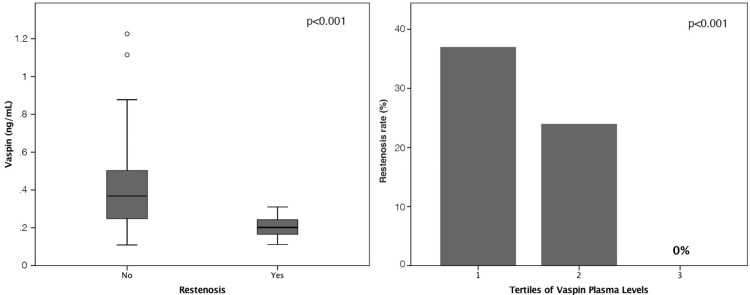
Plasma levels of vaspin before percutaneous coronary intervention (PCI) with implantation of drug-eluting stents.(A) Box plots indicate median, interquartile range (range from the 25th to the 75th percentile), and total range. p<0.001 no restenosis vs. restenosis. Restenosis rates according tertiles of vaspin plasma levels before PCI, p<0.001 (B).